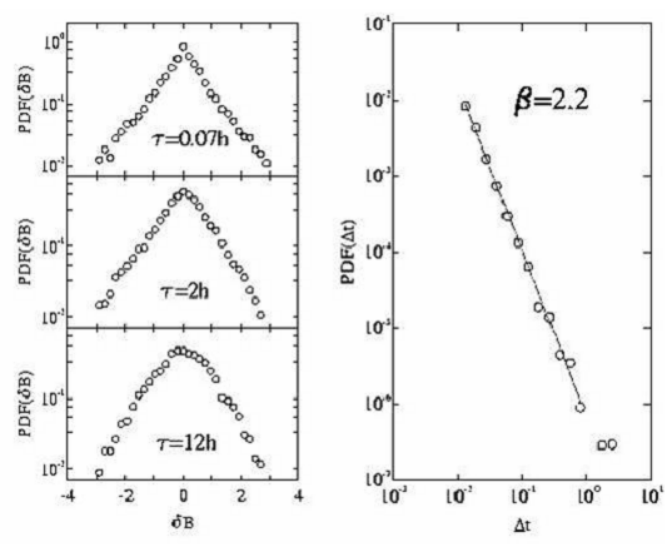
Figure 82: Left panel: normalized PDFs for the magnetic fluctuations observed in the solar wind turbu- lence by using Helios data. Right panel: distribution function of waiting times Δ 𝑡 between structures at the smallest scale. The parameter 𝛽 is the scaling exponent of the scaling relation PDF(Δ 𝑡 ) ∼ Δ 𝑡 − 𝛽 for the distribution function of waiting times.